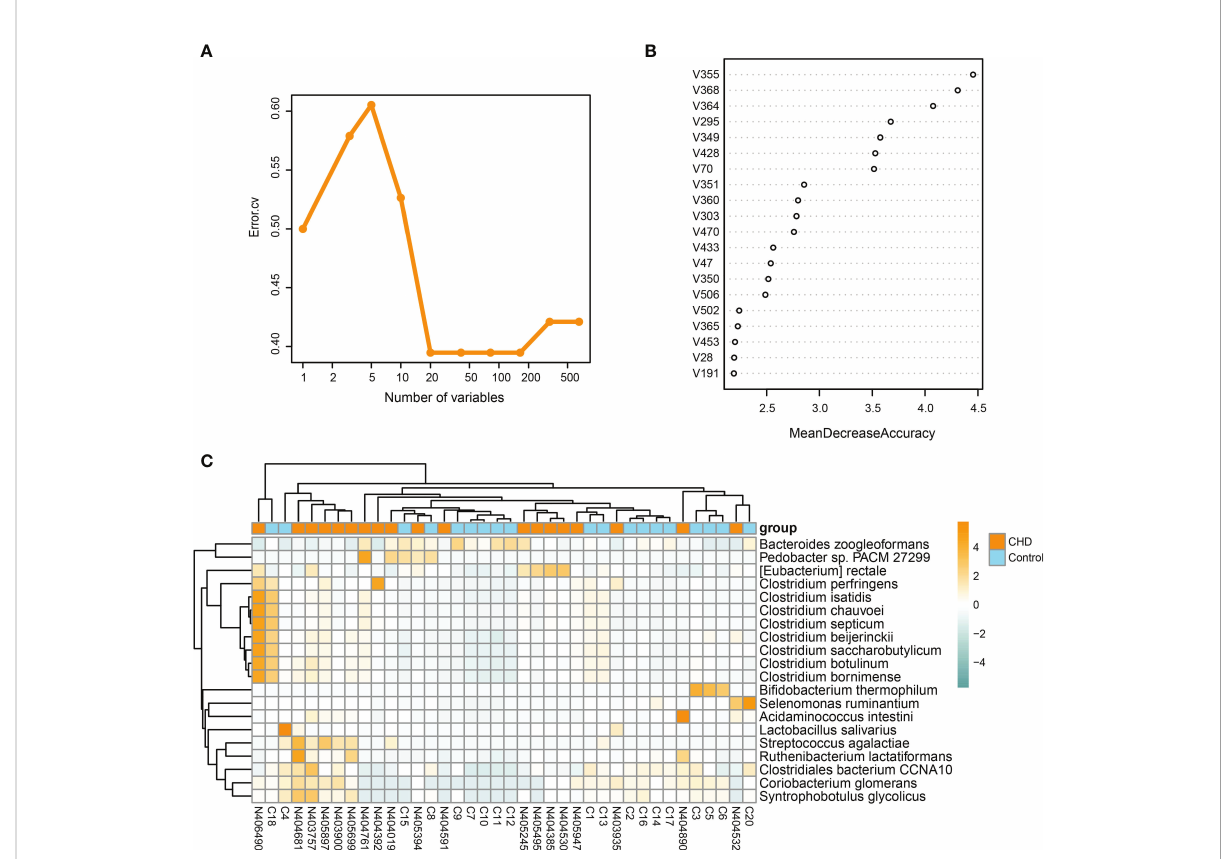
FIGURE 5 Identi fi cation of key signatures between CHD and control groups. (A) 10-fold cross-validation by random forest method identi fi es twenty key signatures. (B) Mean decrease accuracy of species in the random forest model. (C) Relative abundance of twenty key signatures illustrated by